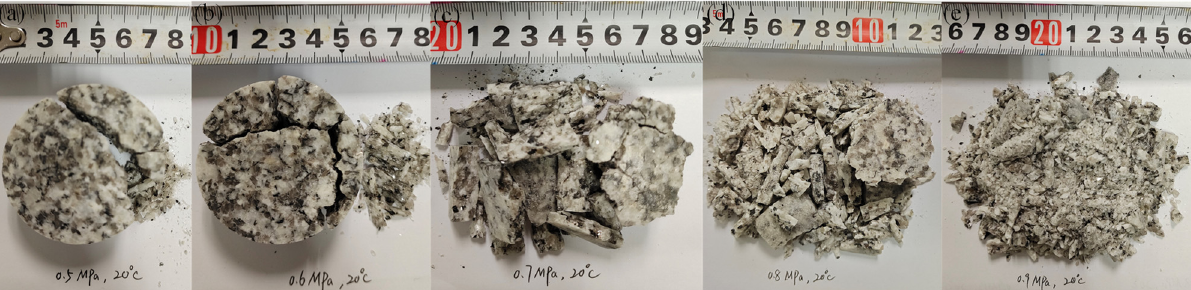
Figure 16. Relationship between fragment degree of specimens and impact gas pressure at 20 °C. ( a ) 0.5 MPa; ( b ) 0.6 MPa; ( c ) 0.7 MPa; ( d ) 0.8 MPa; ( e ) 0.9 MPa.